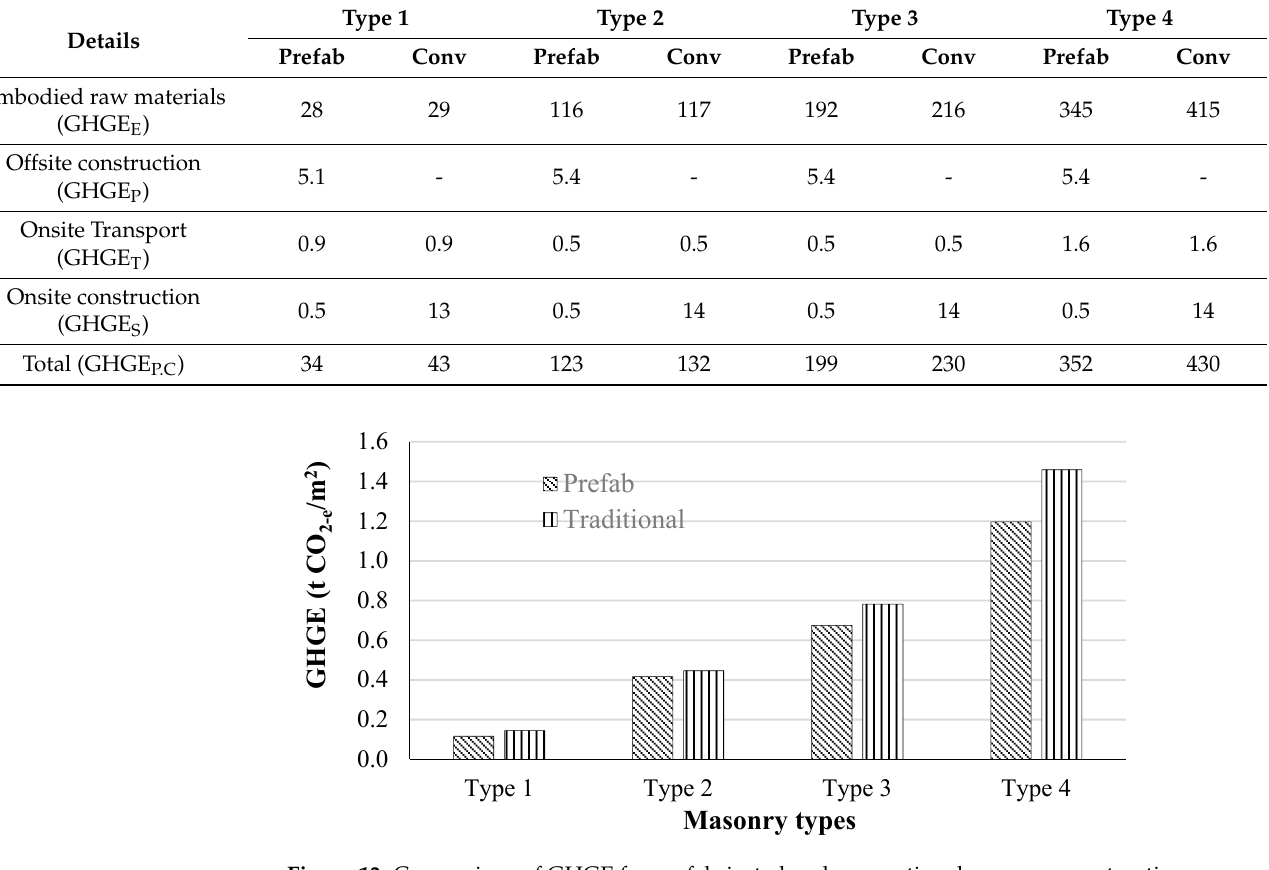
Figure 13. Comparison of GHGE for prefabricated and conventional masonry construction.